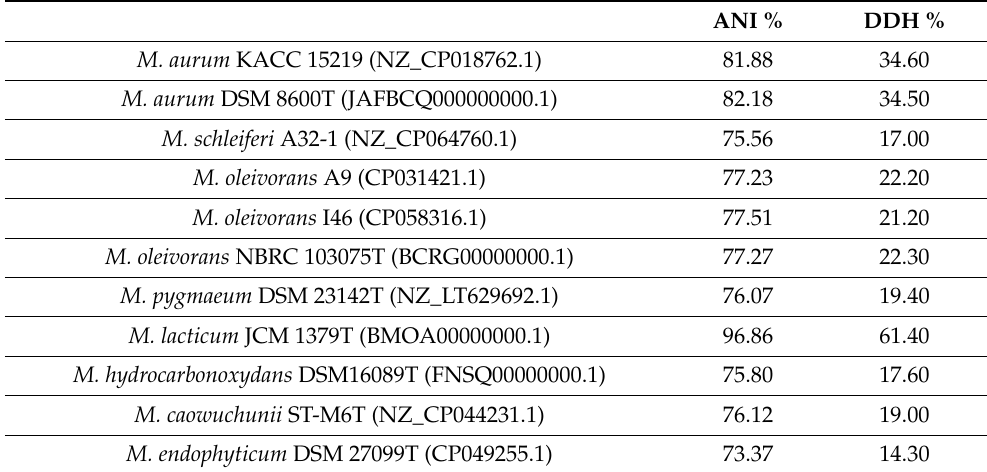
Table 2. Values of ANI and DDH parameters of the strain F2E and its related strains.